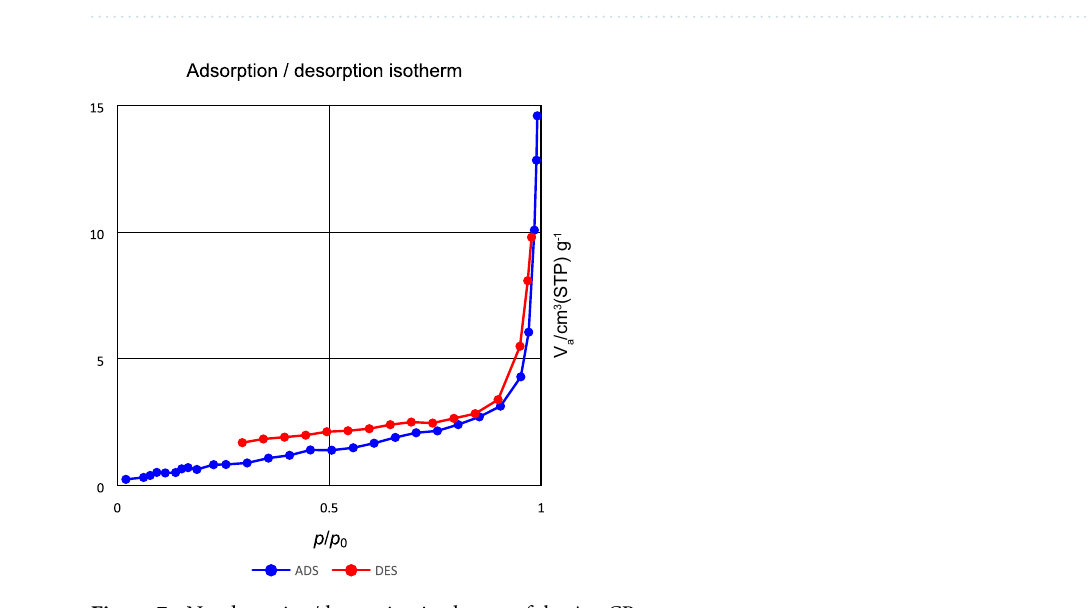
Figure 6. X-ray mapping Analysis of Ag–CP.